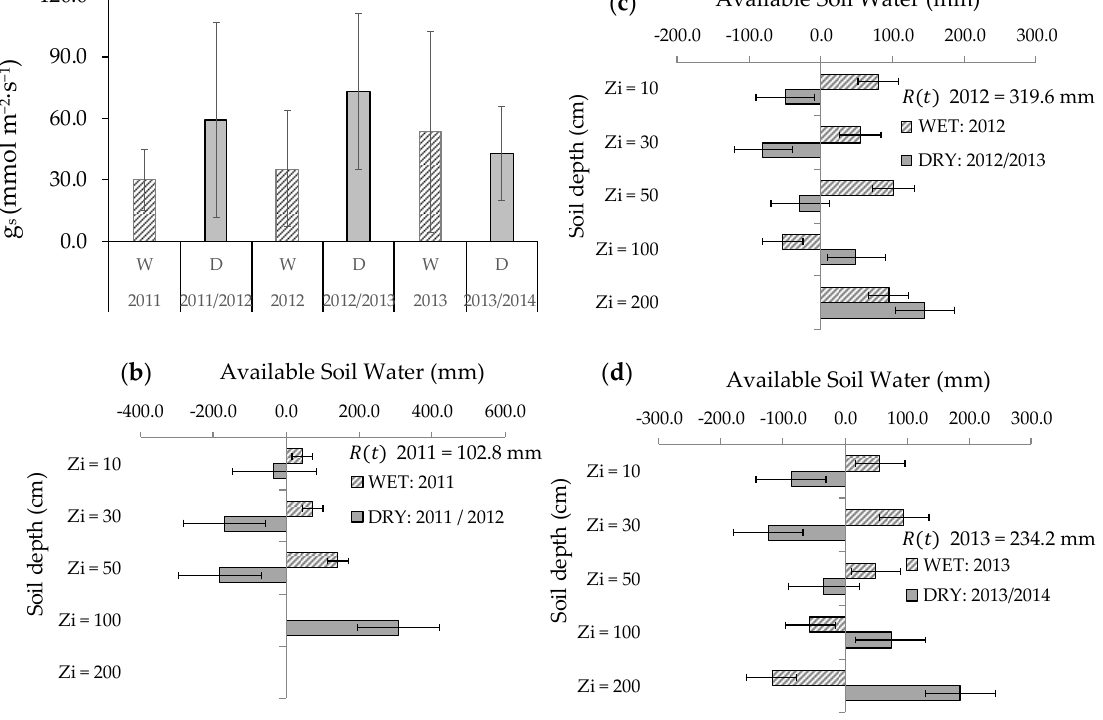
Figure 5. ( a ) Leaf stomatal conductance ( g s ) and ( b – d ) vertical dynamics of available soil water (ASW) content for each soil depth (ASW = ( VWC i − VWC PWP × Z i ) (mm)) based on hourly ASW total values ± 1SD. Balance for the hydrological year was performed considering the period between March and April. Positive values represent “recharge” or “input” of water to the layer i , whereas negative values indicate an “output”. R ( t ) indicates total annual rainfall (mm).